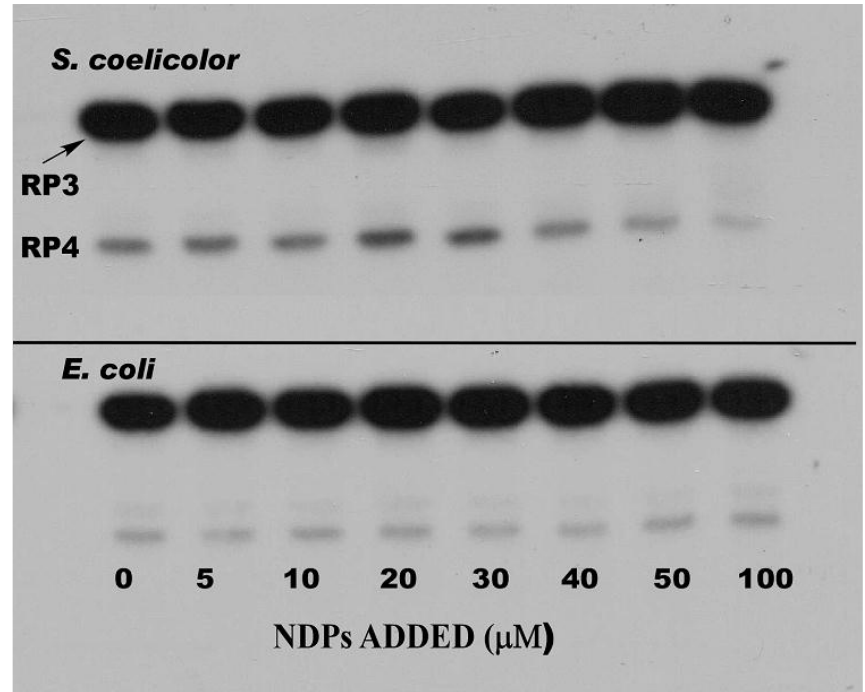
Figure 4. Effects of nucleoside diphosphates on the phosphorolysis of the 5650 transcript. Phosphorolysis reactions were performed as described in [47], and reaction products were separated by gel electrophoresis. The top panel shows the results obtained with S. coelicolor PNPase and the bottom panel results using E. coli PNPase. Reactions were conducted in the presence of increasing concentrations of a mixture of ADP, CDP, UDP, and GDP (nucleoside diphosphates (NDPs)) as indicated. RP3 is the 5650 transcript, and RP4 represents the product obtained by complete digestion of the intergenic hairpin in RP3 by PNPase. Note that as PNPase is highly processive [48], no intermediates with mobilities between those of RP3 and RP4 were observed. Copyright © American Society